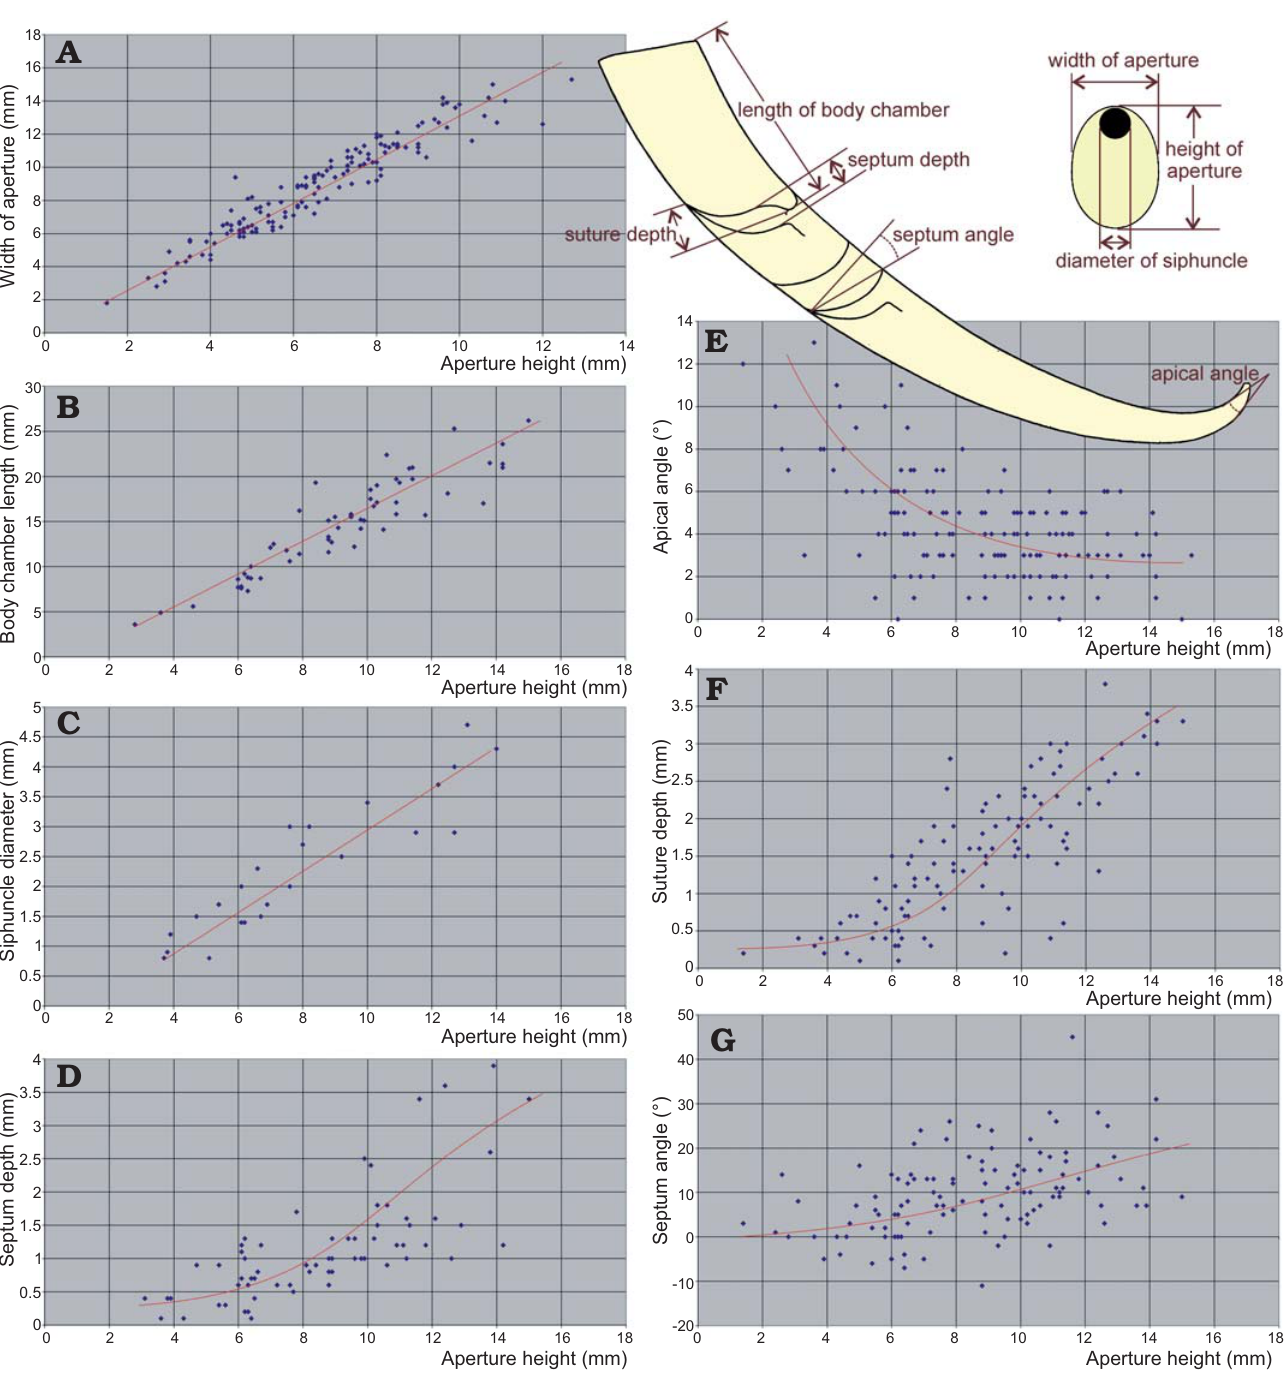
Fig. 11. Ontogenetic change of conch geometry aspects of ellesmeroceratid nautiloids from sample Ang-4, block No. 1, probably latest Furongian Ust-kut Formation found at Pashino on the Angara River, Siberia, Russia. Aperture height is used as a measure of an individual age. A – C . Characters with linear growth pattern. D – G . Characters with non-linear growth pattern. The regression lines are intuitive (drawn by hand and not computed) because only one dimension (aperture height) is measurable in smallest